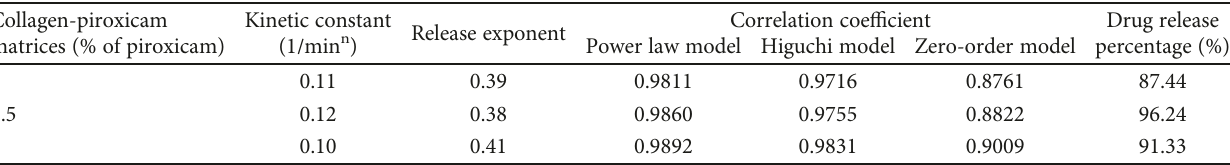
Table 2: Kinetic parameters and correlation coe ffi cients speci fi c to power law model, correlation coe ffi cients speci fi c to Higuchi and zero- order models, and drug release